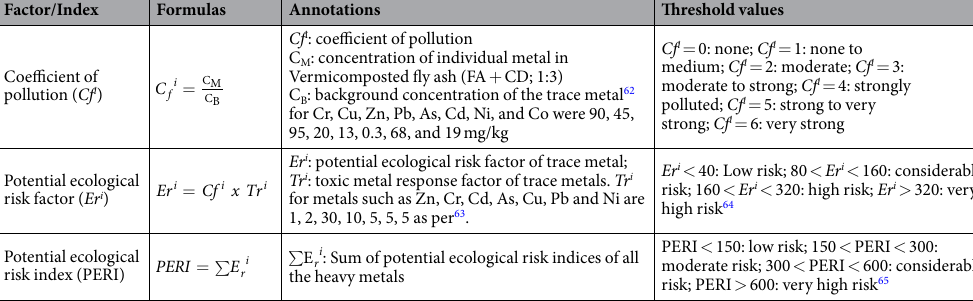
Table 7. Factors/Indices to determine potential ecological risk of vermicomposted fly ash to the environment.